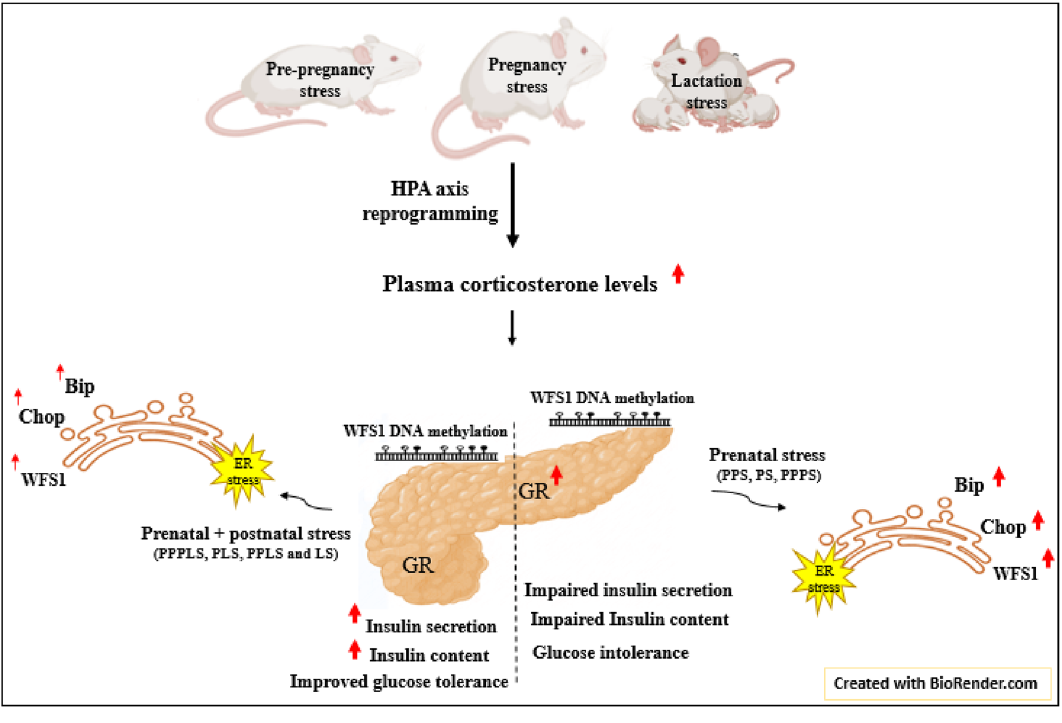
Figure 8. Summary of